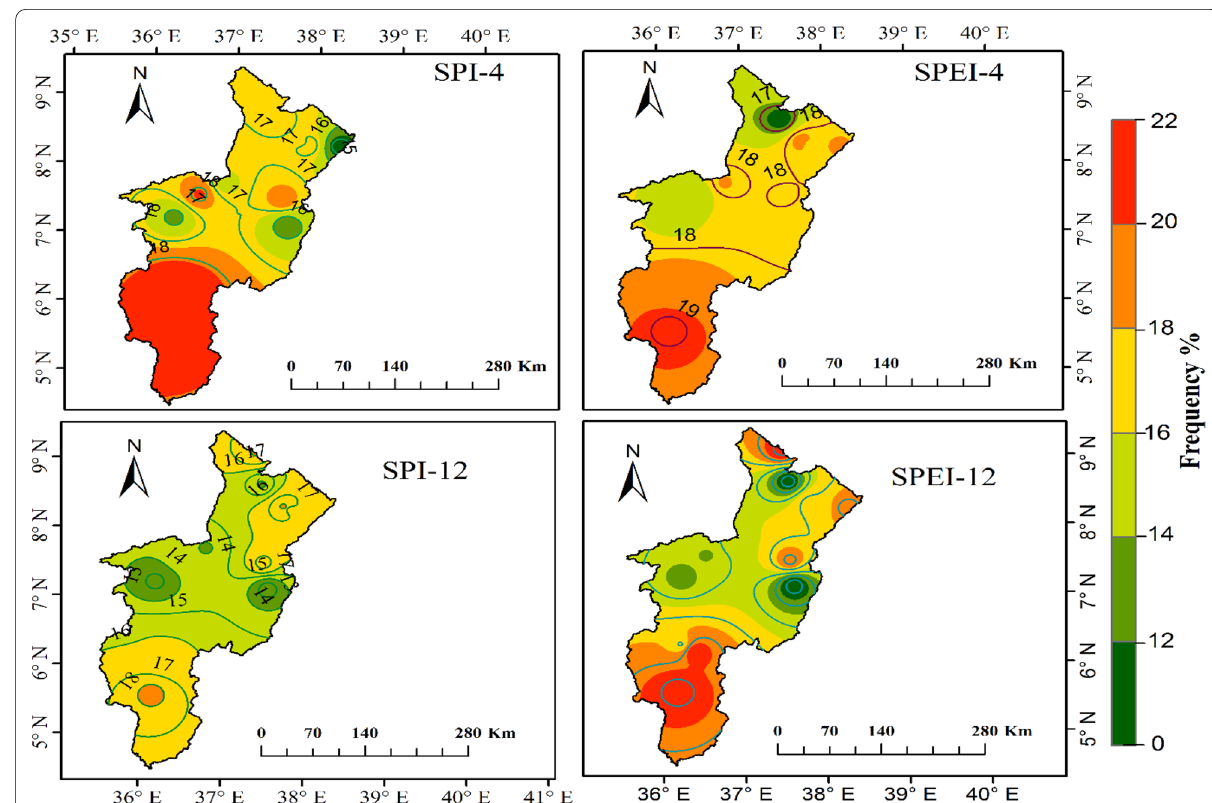
Fig. 5 Spatial distribution of drought frequency in different degrees for SPI/SPEI in 04- and 12-time scale in OGRB from 1981 to